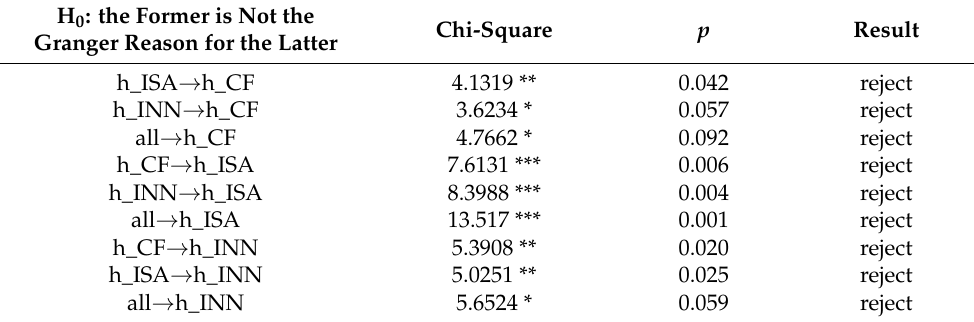
Table 7. Granger causality